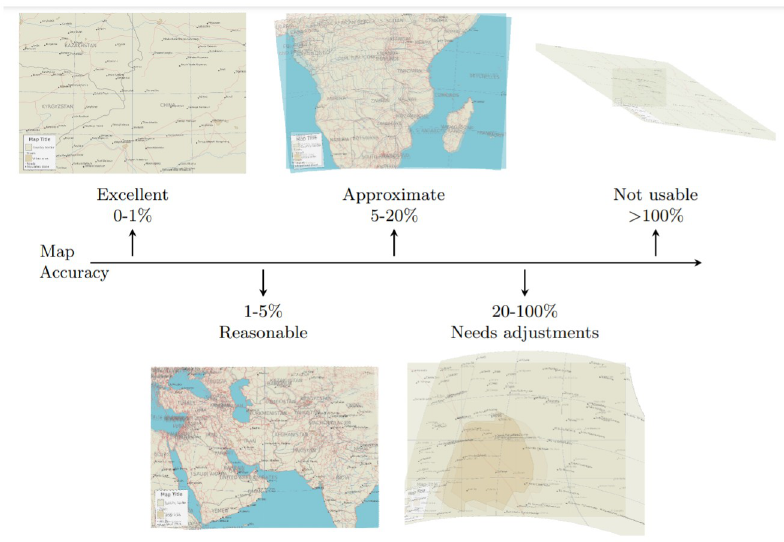
Fig 6. Simulated map accuracy categories. Shows example georeferenced maps overlaid on source maps with known coordinates. Map accuracy is calculated based on normalized maximum map error (as a percentage of image radius). The simulated maps were generated based on public domain data from © Natural Earth, including data on country outlines, populated places, urban extents, rivers, and roads.